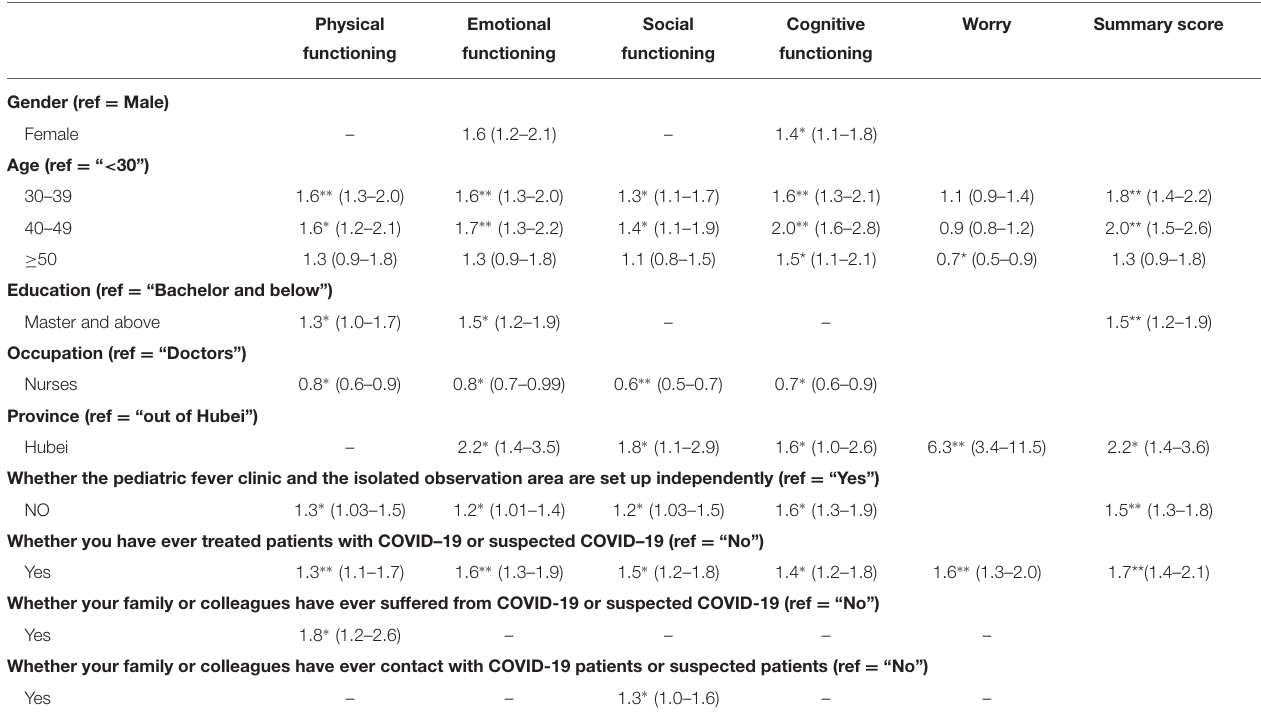
TABLE 3 | Logistic regression analysis of HRQoL.